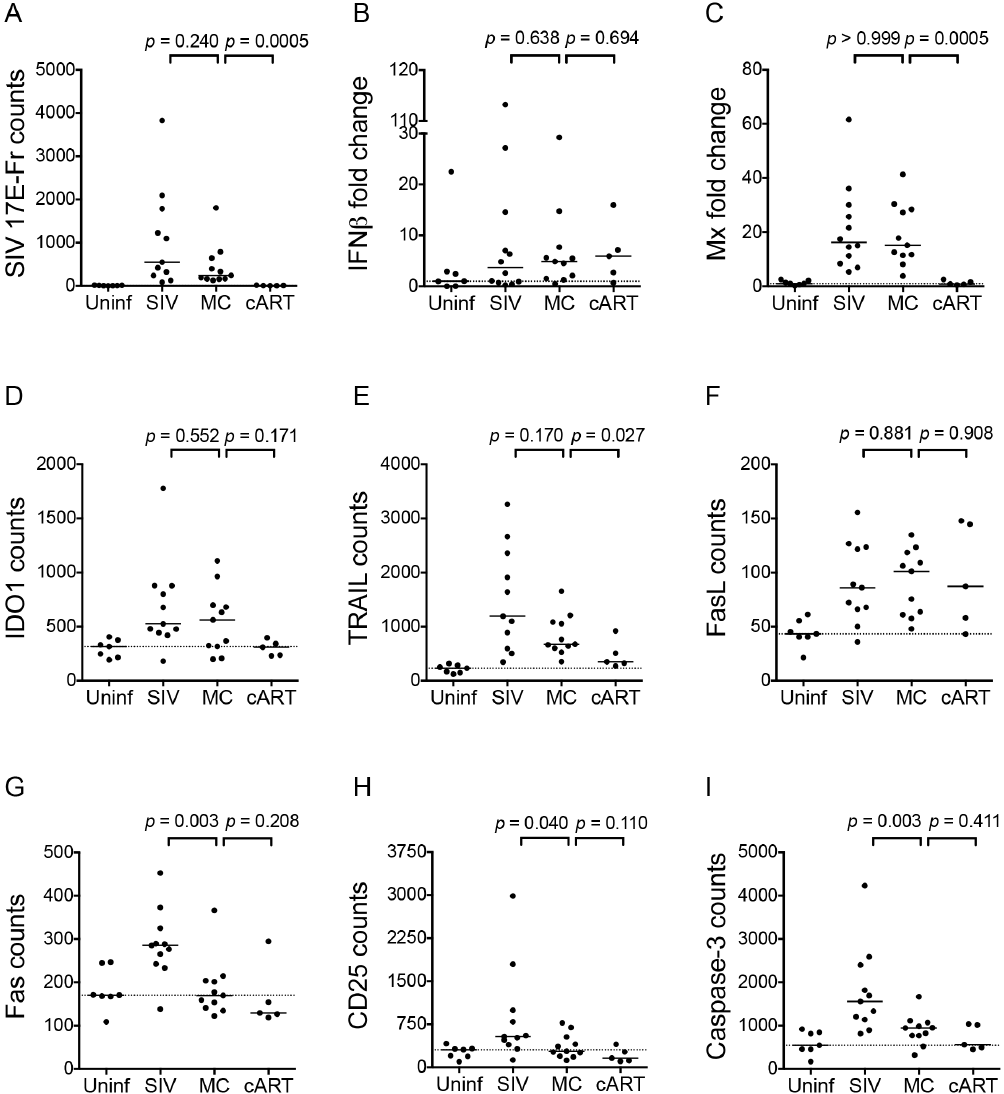
Figure 4. Minocycline attenuates activation but not IFN responses in spleens of SIV-infected pigtailed macaques. ( A–I ) The RNA expression of virus and 8 genes putatively involved in HIV/SIV pathogenesis were analyzed in RNA from archived spleens of uninfected controls (Uninf; n =7), chronically SIV-infected pigtailed macaques (SIV; n =11), chronically SIV-infected pigtailed macaques treated with minocycline starting at day 21 p.i. (MC; n =11), and SIV-infected pigtailed macaques treated with cART starting at day 12 p.i. (cART; n =5). All genes were analyzed by Nanostring nCounter analysis with the exception of IFN b ( B ) and Mx ( C ), which were analyzed by qRT-PCR. Nanostring data are represented as counts; qRT-PCR data are represented as fold change over the median of 7 uninfected animals, although statistics were performed on delta Ct values prior to transformation. Solid lines denote medians; dashed lines represent the medians of uninfected controls. Data were analyzed by Mann-Whitney test.